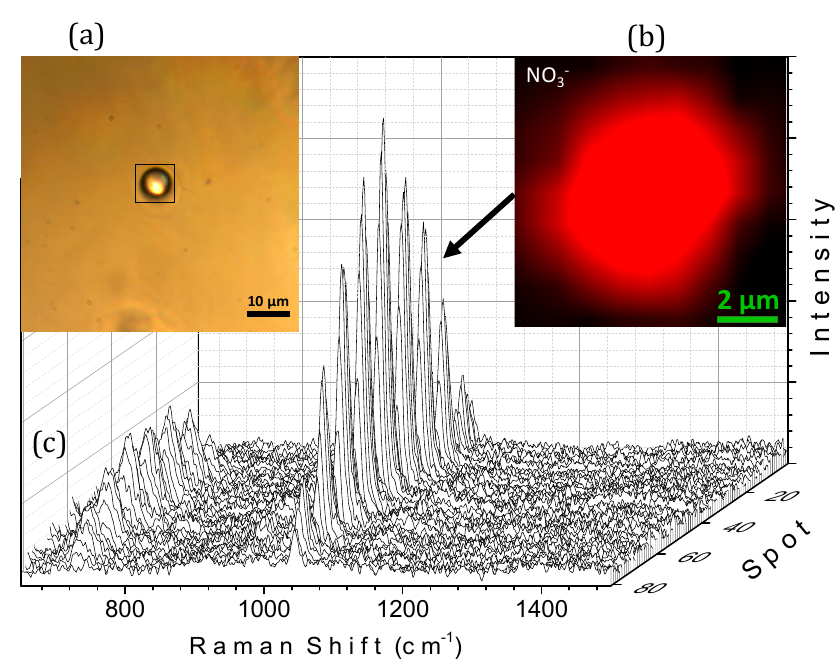
Figure 4. Optically levitated droplet containing aqueous NaNO 3 before irradiation. ( a ) optical image showing the region of interest defined by the black frame; ( b ) Raman image of the region of interest reconstructed from the 1020–1070 cm − 1 spectral range after base line correction and smoothing procedure; ( c ) Raman spectra of each spot, recorded using an excitation laser at 532 nm.